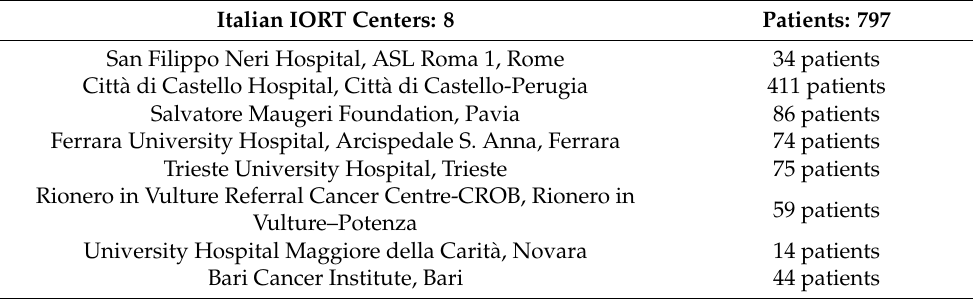
Table 1. Radiotherapy centers participating in the study and patients analyzed. Italian IORT Centers: